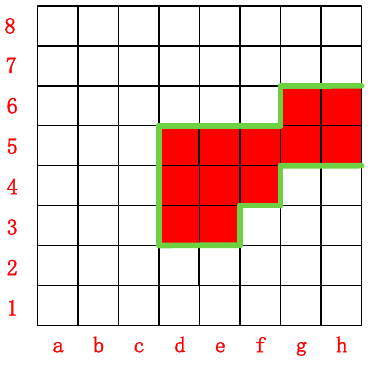
Figure 2. Process of the edge detection of the image.